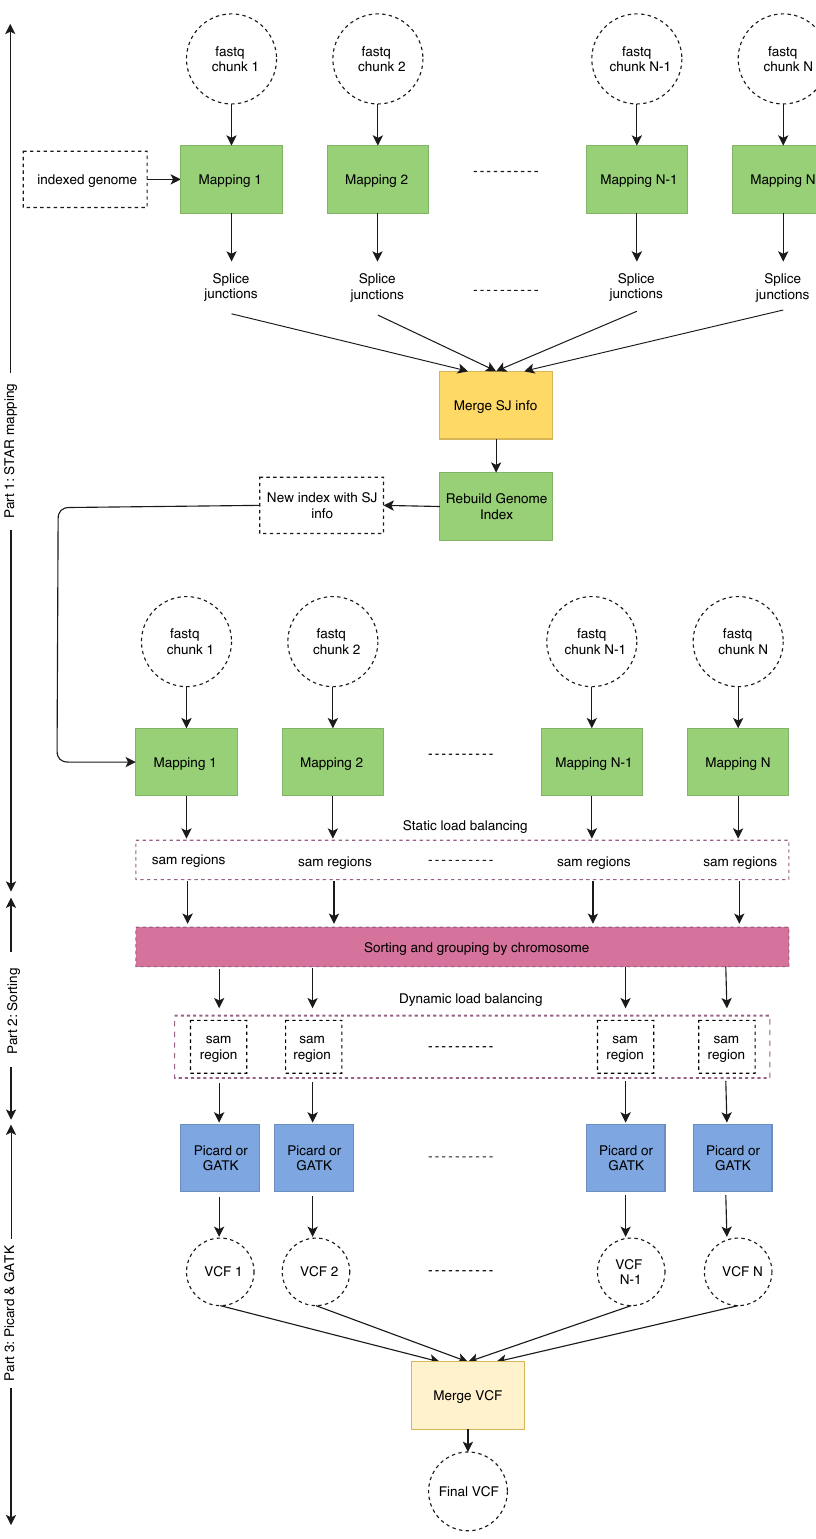
Figure 4. Execution flow of the SparkRA